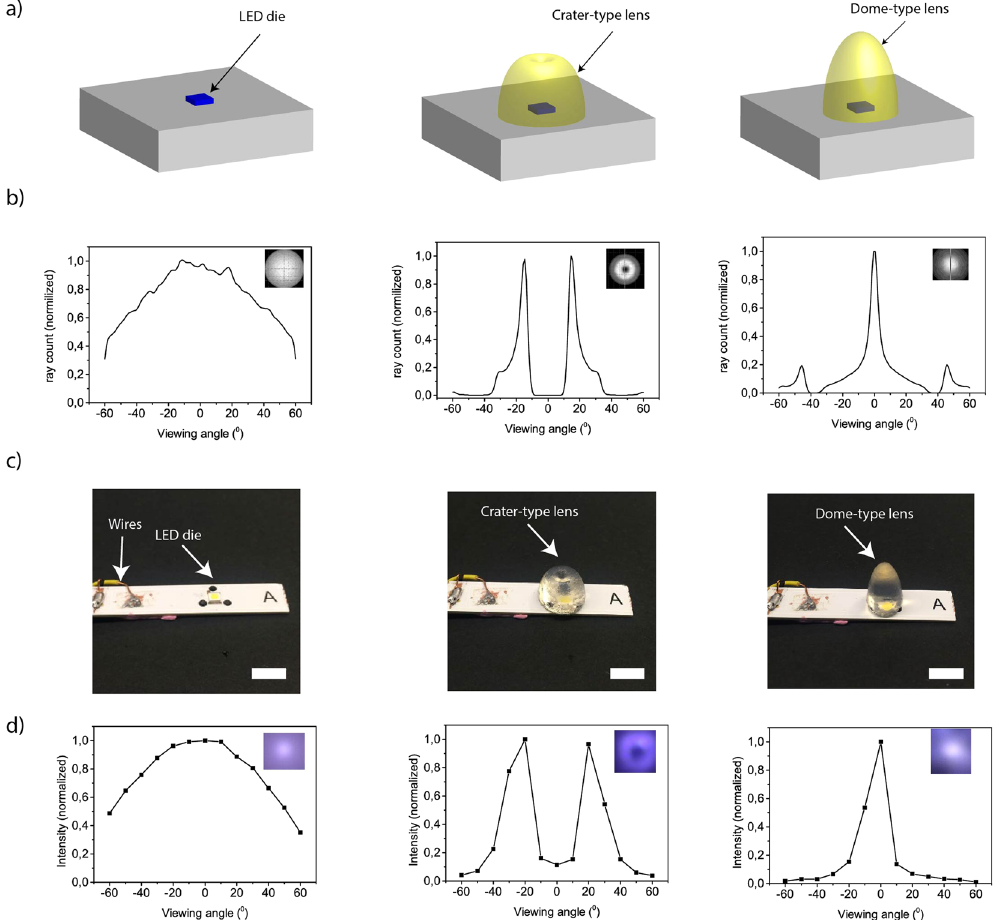
Figure 2. ( a ) Schematic representation of LED die (left), crater-type silk hydrogel lens on LED die (middle) and dome-type silk hydrogel lens on LED die (right). ( b ) Intensity distribution of spatial radiation of ray tracing simulation (without scattering effects). Inset: spatial radiation distribution. ( c ) Photographs of LED chip used for experimental testing (left), LED covered with crater-type hydrogel lens (middle) and dome-type hydrogel lens (right). Scale bar, 1 cm. ( d ) Experimental intensity distribution of spatial radiation of the LEDs. Inset: photographs of spatial radiation